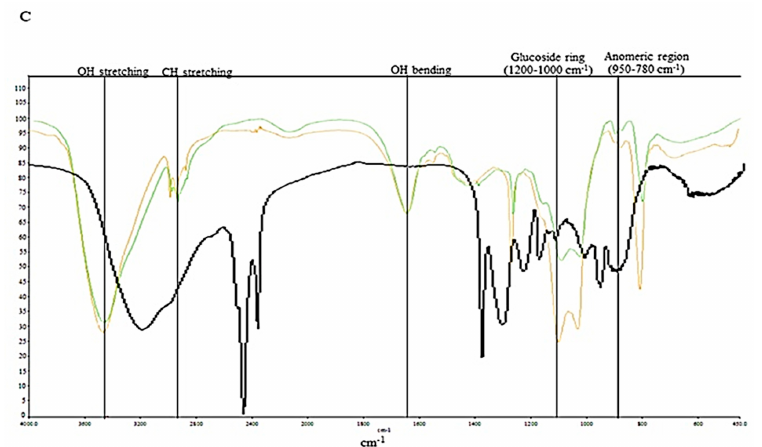
Figure 8. IR spectra of cow ( A ), buffalo ( B ) and goat ( C ) kefirans extracted with cold water (black line), hot water (orange line), and mild heat ‐ ultrasounds (green line) between 4000 and 450 cm —1 . 4. Discussion Kefiran was extracted using two traditional methods involving water as the extrac ‐ tion solvent at different temperatures (25 °C and 90 °C, method I and II, respectively) and one advanced methodology performed with ultrasound and a mild heat temperature (65 °C) [19]. The three methodologies were tested on three types of animal milk (cow milk indicated by A, buffalo milk indicated by B, goat milk indicated by C) to assess the influ ‐ ence of the nature of the dairy matrix on the characteristics of the biopolymer of interest. The results showed that the kefiran yield varied depending on the type of milk and on the extraction method. The lowest percentages (less than 0.5%) were recorded for all polymers extracted at room temperature: goat kefiran was recovered with 0.15 ± 0.02% yield, while buffalo kefiran was three times more (0.48 ± 0.05%). The use of high extraction tempera ‐ tures improved the yield in all three milks, as higher temperatures facilitate the penetra ‐ tion of water into the grains, increasing the solubilisation of the exopolysaccharide and the extraction yield [36]. On the other hand, high temperatures could cause thermal deg ‐ radation of the biopolymer leading to changes in its actual structure. For this reason, it was decided to combine mild temperatures with the use of ultrasound to reduce the ex ‐ traction times. Vilkhu et al. [37] found that sonication at 68 °C for 32 min increased the